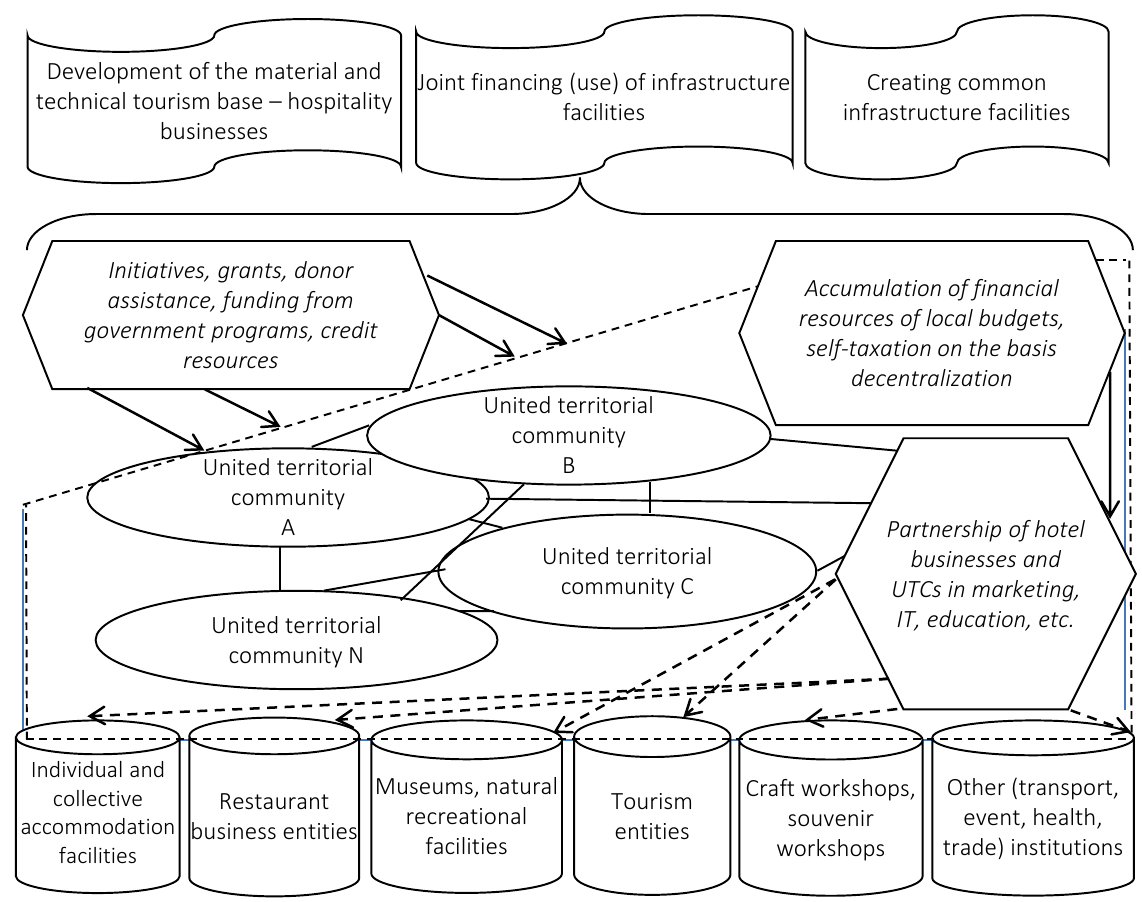
Figure 3. Architectonics of relationships between UTCs and hotel and tourism business entities in the fiscal